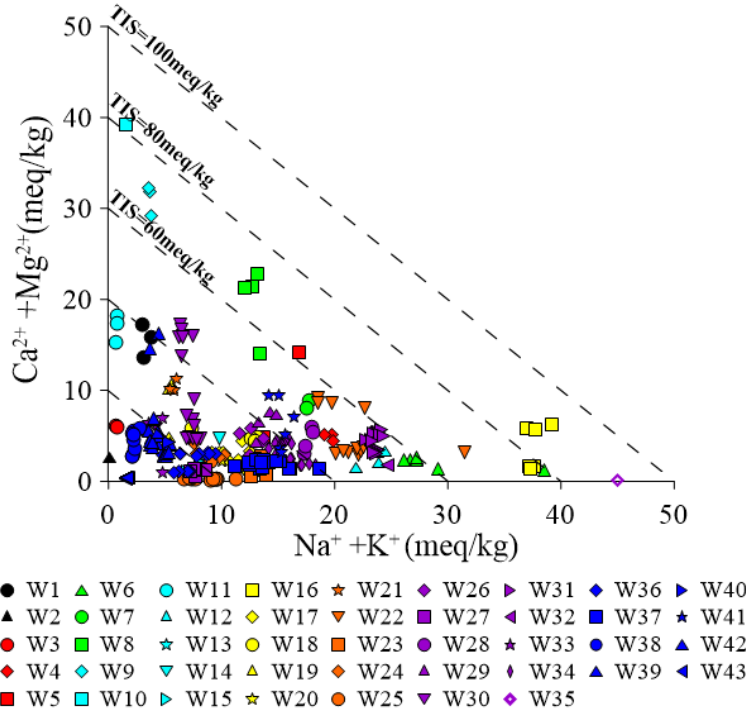
Figure 4. Correlation plot of Na + +K + vs. Ca 2+ +Mg 2+ for the spring water samples along XSHF, also showing iso-ionic-salinity lines for reference.